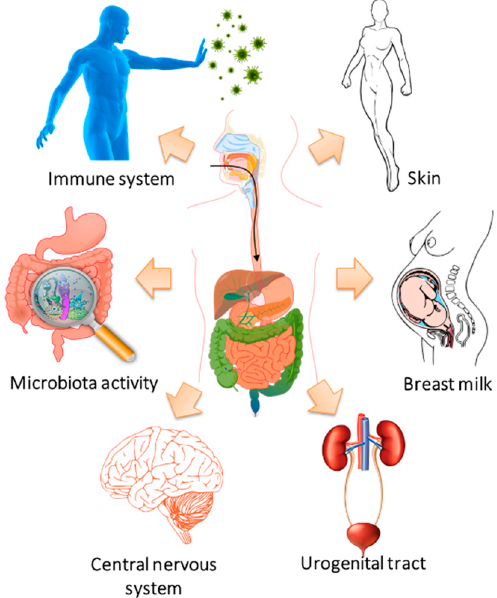
Figure 5. Schematic representation of the health benefits after probiotic consumption [113].